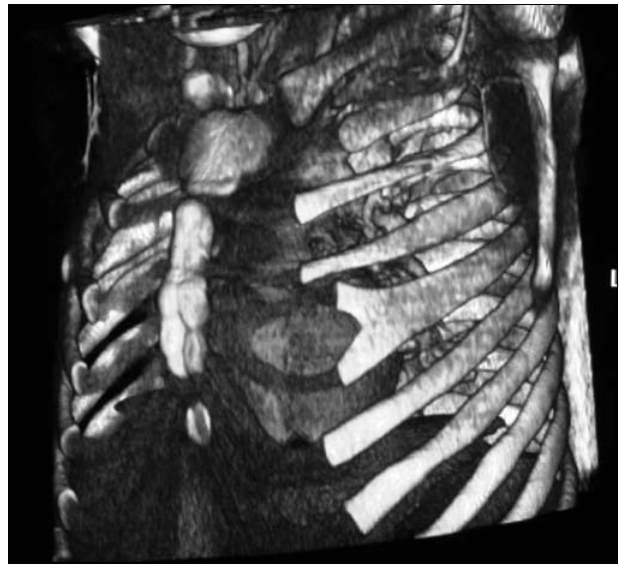
Fig 2. A 3D MDCT reconstruction, with volume rendering, confirming the presence of a left 4th bifid